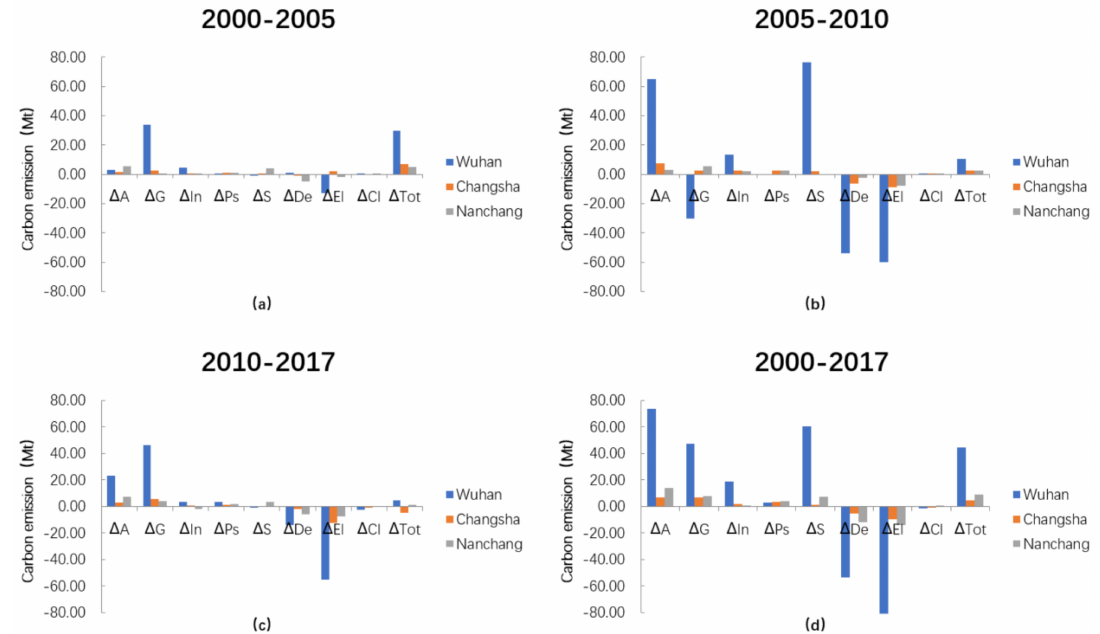
Figure 4. Factors influencing carbon emissions for ( a ) 2000–2005, ( b ) 2005–2010, ( c ) 2010–2017, and ( d ) 2000–2017 in the three